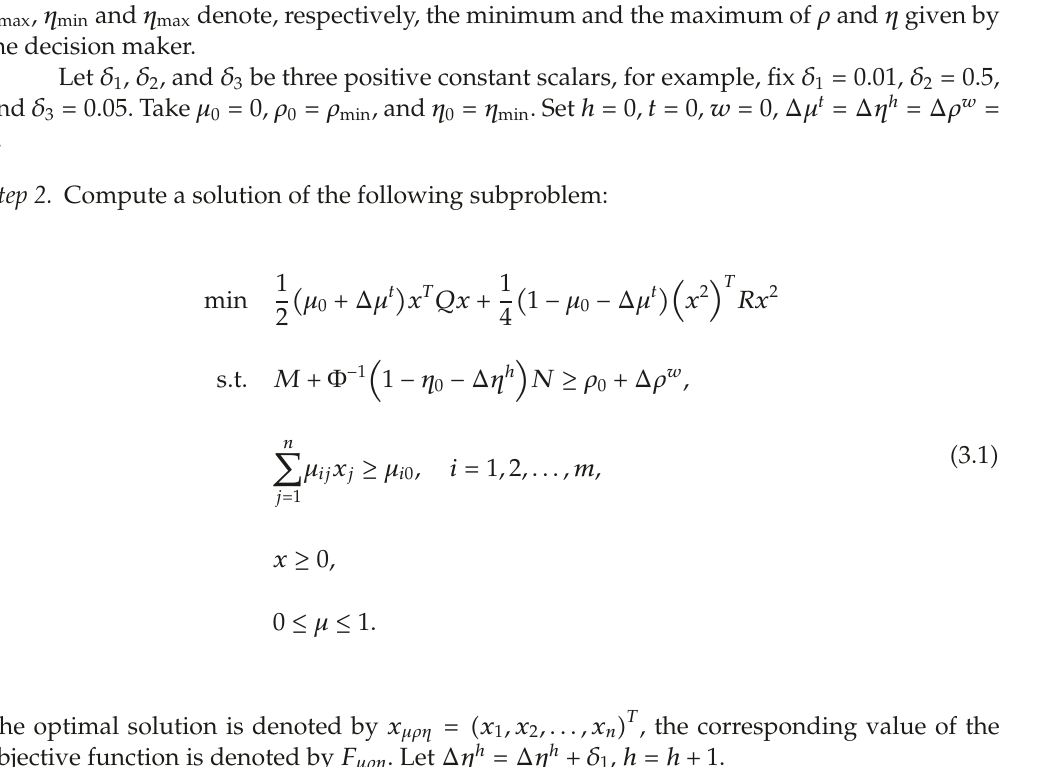
Algorithm 3.1 (cid:2) Interactive Algorithm for Stochastic Bi-criteria Problems (cid:3)